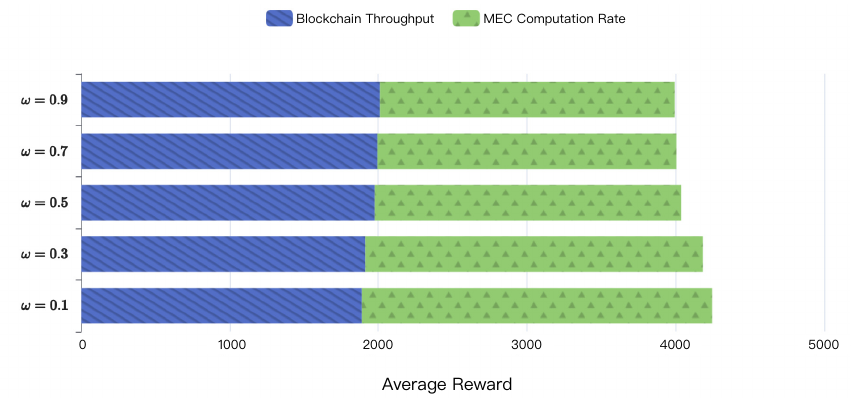
Figure 13. The effect of different weight factors on average